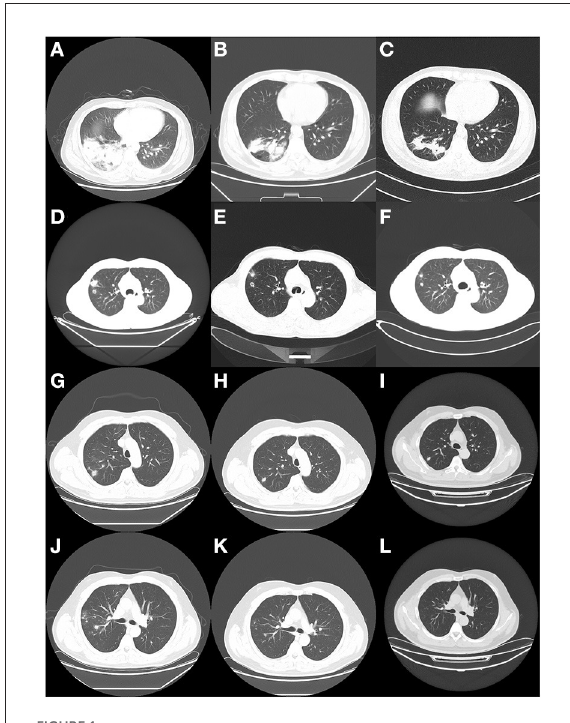
FIGURE1 CT findings of the three patients at different periods. (A) The enhanced CT scan of patient 1 on the second day of admission showed a right lower lung lesion. (B) 1 month after discharge, CT reexamination of patient 1 showed a reduction of the lesion. (C) 3 months after discharge, CT reexamination of patient 1 showed a continuous reduction of the lesion. (D) CT scan of FIGURE2